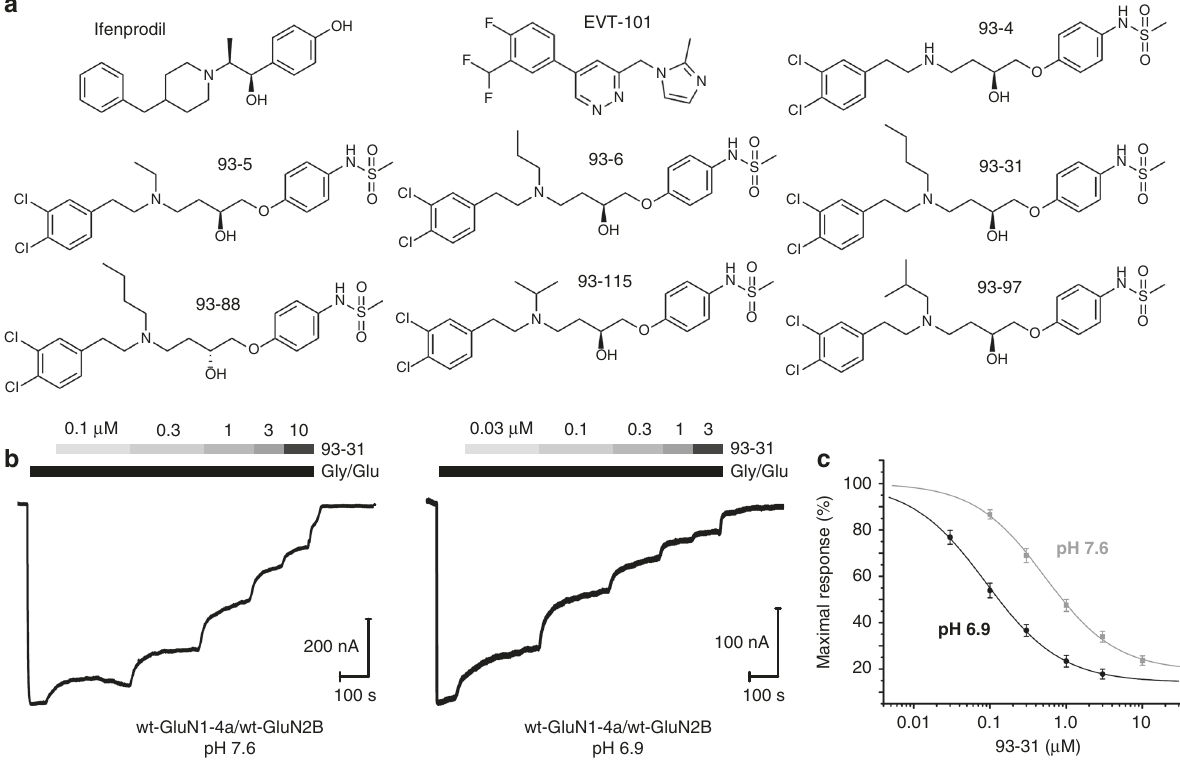
Fig. 1 pH-sensitive negative allosteric modulators of GluN2B-containing NMDA receptors. a The 93-series compounds 28 are shown together with the phenylethanolamine ifenprodil and EVT-101. b Representative TEVC recordings of wild-type GluN1-4a/GluN2B NMDA receptors in Xenopus oocytes are shown in response to maximally effective concentration of glutamate and glycine (100 and 30 μ M, respectively). When normalized to the maximal response, recordings at pH 6.9 showed substantially higher potency of 93-31 than at pH 7.6. c Concentration – response curves from TEVC experiments at pH 7.6 (gray) and 6.9 (black) for inhibition of wild-type GluN1-4a/GluN2B NMDA receptor by 93-31 (also see Table 2). Symbols and error bars represent mean ± S.E.M.; the number of replicates is listed in Table